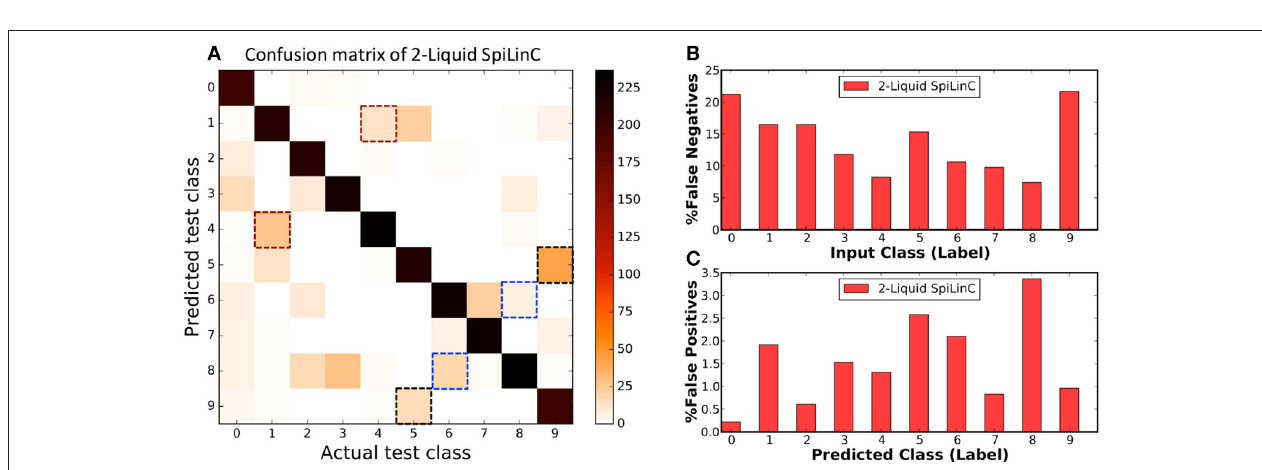
FIGURE 5 | (A) Confusion matrix of two-liquid SpiLinC with 1,600 neurons per liquid trained on 29,000 digit utterances from the TI46 speech corpus. (B) Percentage of false negatives predicted by the two-liquid SpiLinC for every input class. (C) Percentage of false positives produced by the two-liquid SpiLinC for every predicted